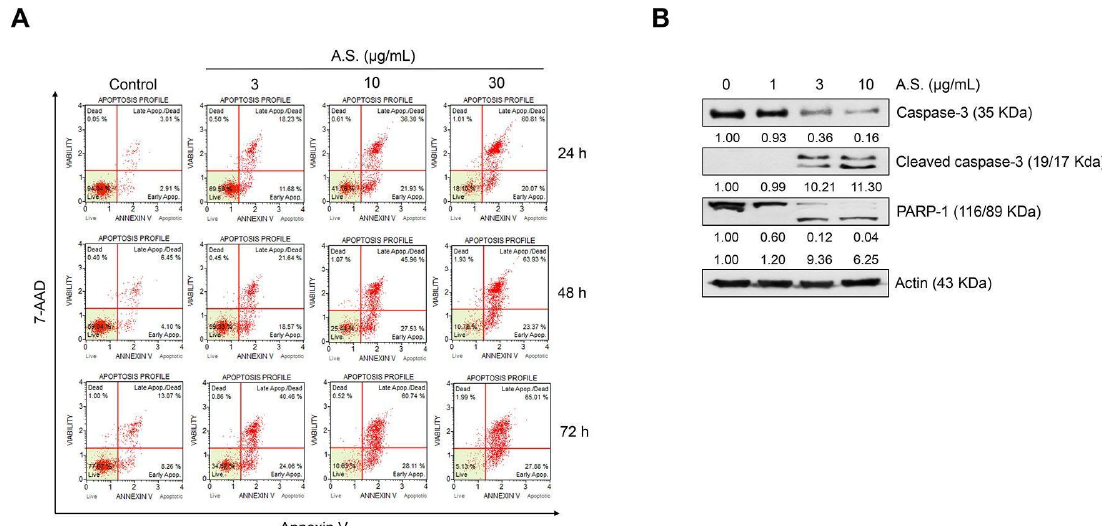
Figure 2. A.S. extract induces caspase-dependent apoptosis in T-ALL Jurkat cells. ( A ) Jurkat cells were treated with A.S. extract for 24–72 h and the apoptotic cells were analyzed using the MUSE® Cell Analyzer. ( B ) After A.S. extract treatment to Jurkat cells for 24 h, protein expression of caspase-3 (cytosol), cleaved caspase-3 (cytosol), and PARP-1 (nucleus) was measured by Western blot using 10% (caspase-3 and actin), 15% (cleaved caspase-3), and 8% (PARP-1) polyacrylamide gels. Actin was used as a loading control against cytosolic and nuclear fractions. The detected band intensities were quantified based on the ImageJ software, and the relative ratio between proteins were normalized by